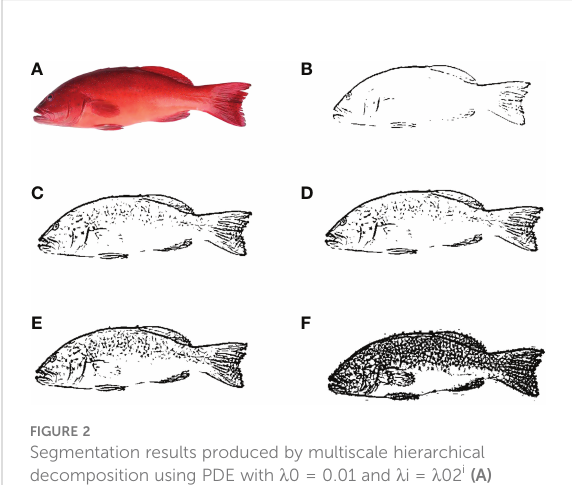
FIGURE 2 Segmentation results produced by multiscale hierarchical decomposition using PDE with l 0 = 0.01 and l i = l 02 i (A) original image; (B – F) segmented image at scaling parameters l 1, l 2, l 3, l 4, and l 5,